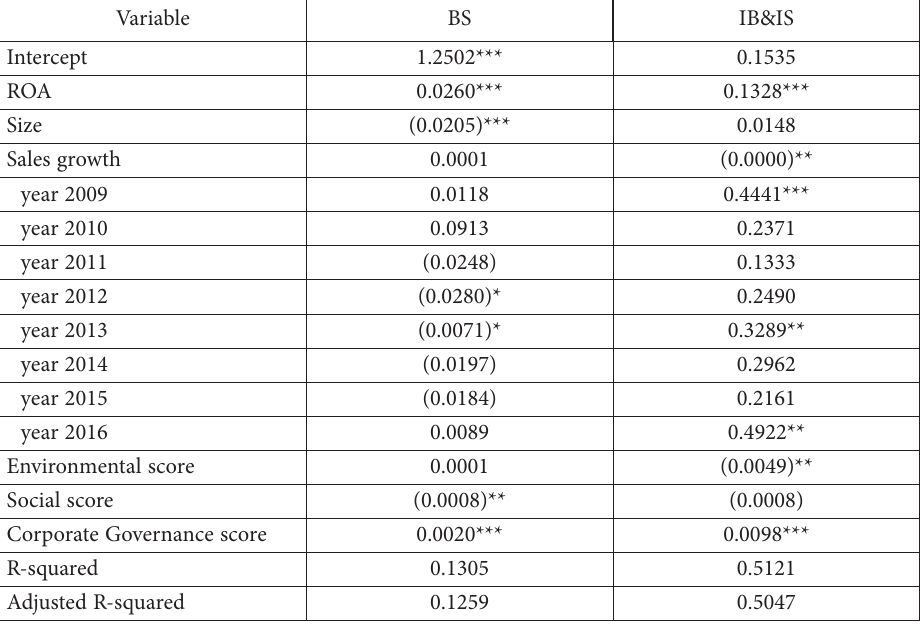
Table 2. Regression results for Tobin’s q – Banking Services (BS) and Investment Banking & Investment Services